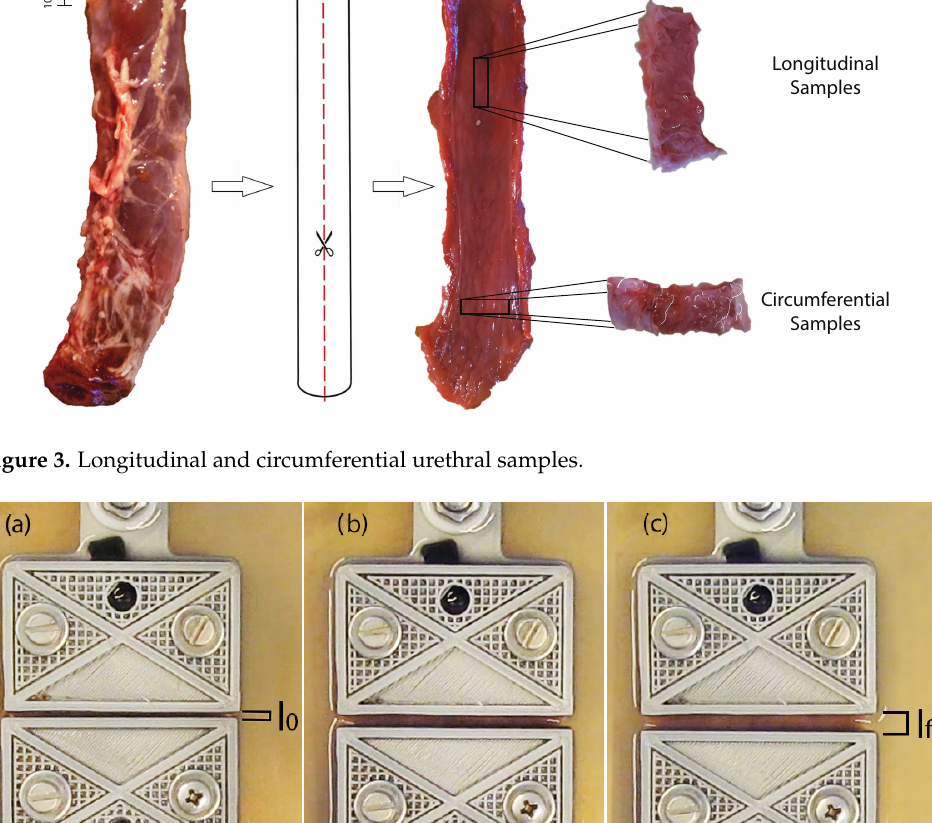
Figure 4. Sample testing for the first cycle: ( a ) initial deformation at t = t 1 ate deformation; ( c ) final deformation at t = t 1